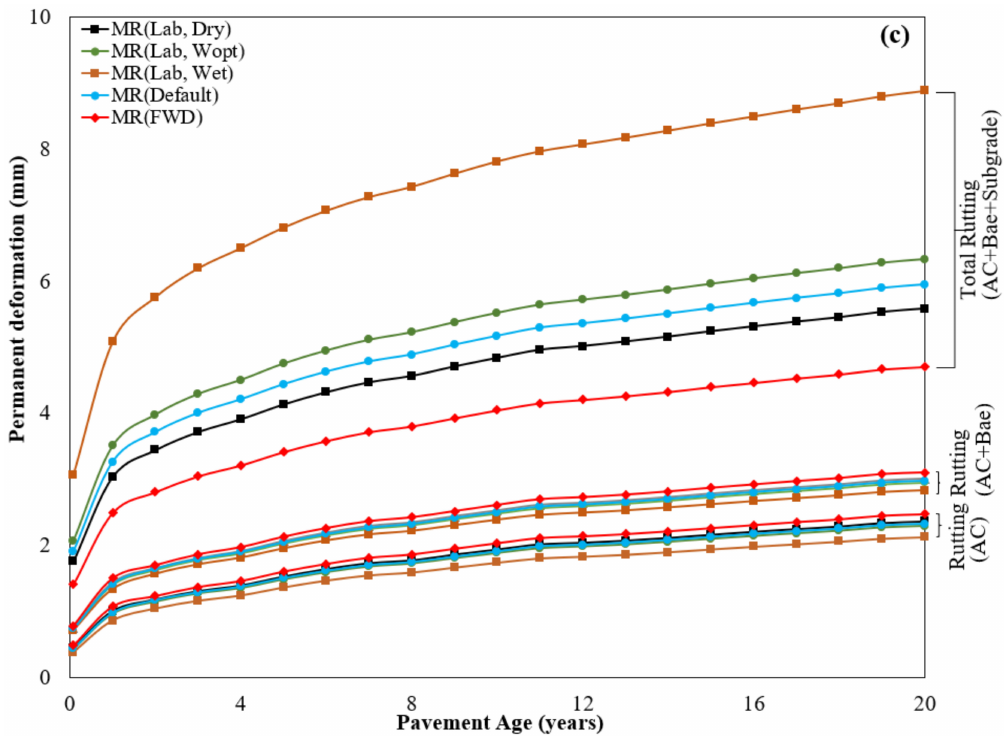
Figure 9. Effects of Subgrade M R on Pavement Rutting: ( a ) Pavement A, ( b ) Pavement B, and ( c ) Pavement